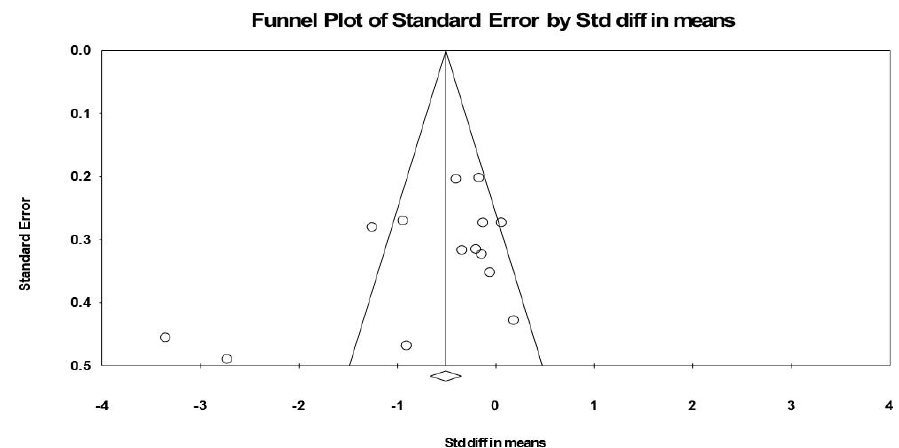
Figure 4. Funnel plot of psychomotor performance following (poly)phenols-rich supplementation, showing evidence of publication bias.